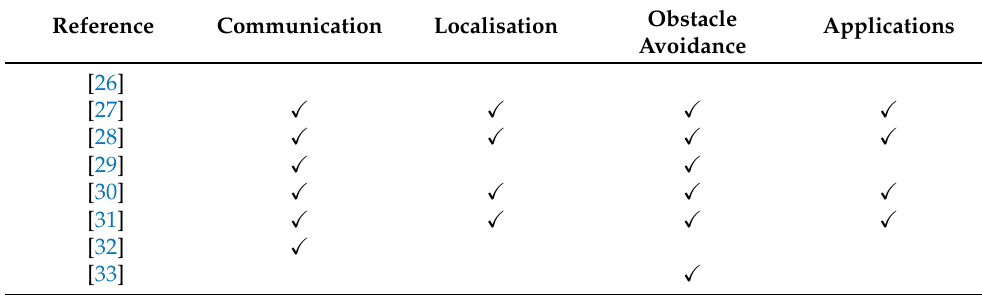
Table 1. Aggregation of research